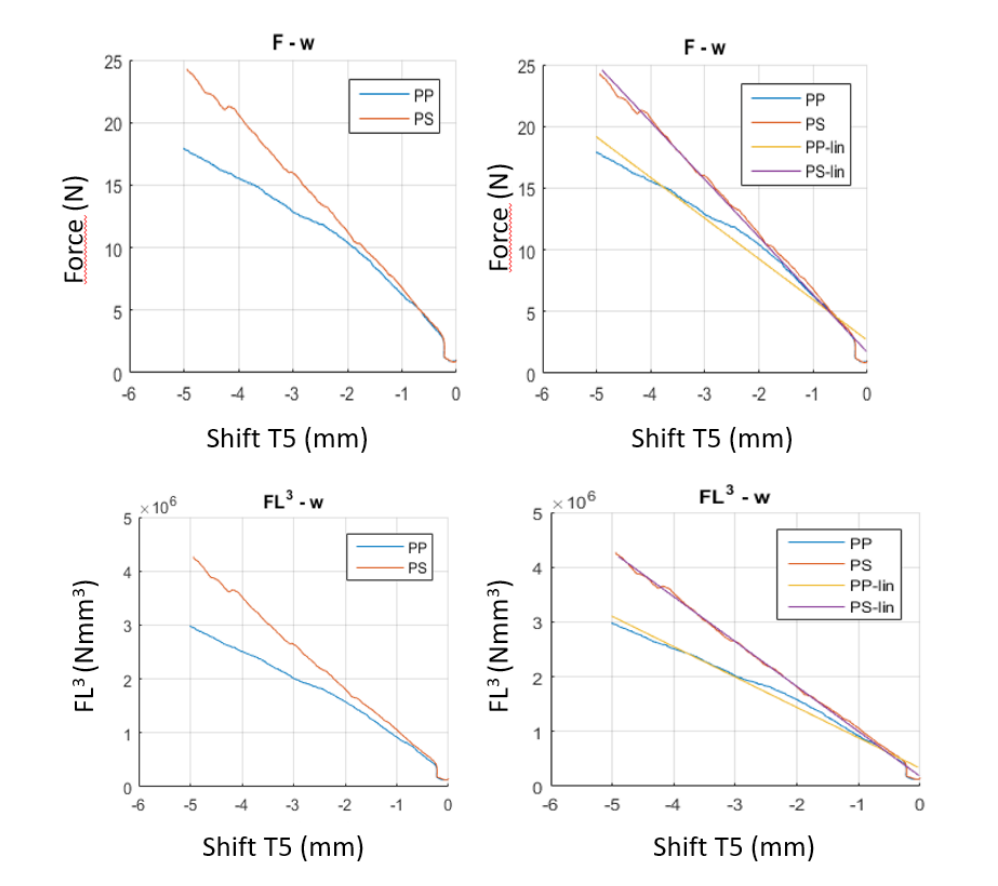
Fig. 6. Results for specimen 6, loading b. PP (plate-plate), PS (plate-screw), PP-lin (linear regression), PS-lin (linear regression)